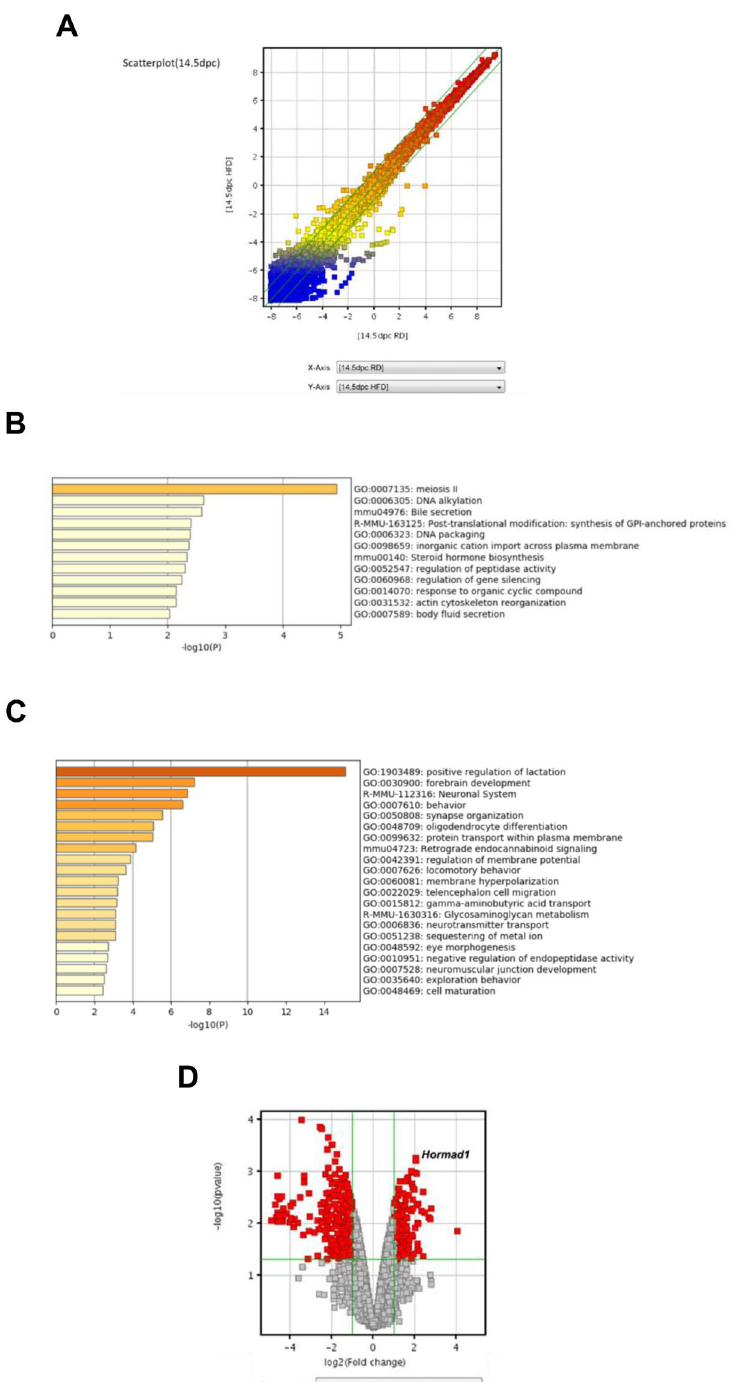
Figure 2. Maternal HFD consumption upregulates Hormad1 gene expression in the fetal liver. ( A ) Scatterplot of the gene expression profiles for hepatocytes from fetuses (14.5 dpc). Green lines indicate the cutoffs for twofold up- and downregulation. Enrichment scores obtained from the Gene Ontology enrichment analysis of the selected mRNAs. ( B ) GO analysis of the upregulated genes in livers from fetuses of HFD-fed dams compared with CD-fed dams. ( C ) GO analysis of the downregulated genes in livers from fetuses of HFD-fed dams compared with CD-fed dams. ( D ) Volcano plots of the gene expression data. The horizontal axis represents the log2 (fold change), and the vertical axis represents the − log 10 (p value). The red plots represent the selected DEGs. Volcano plot showing Hormad1, which had the lowest p value ( p = 0.0006), and a greater than four-fold change (log2 = 2.037) in expression in livers from fetuses of HFD-fed dams compared with CD-fed dams. Data are presented using GeneSpring software 12.1 (Agilent Technologies. https:// www. agile nt.